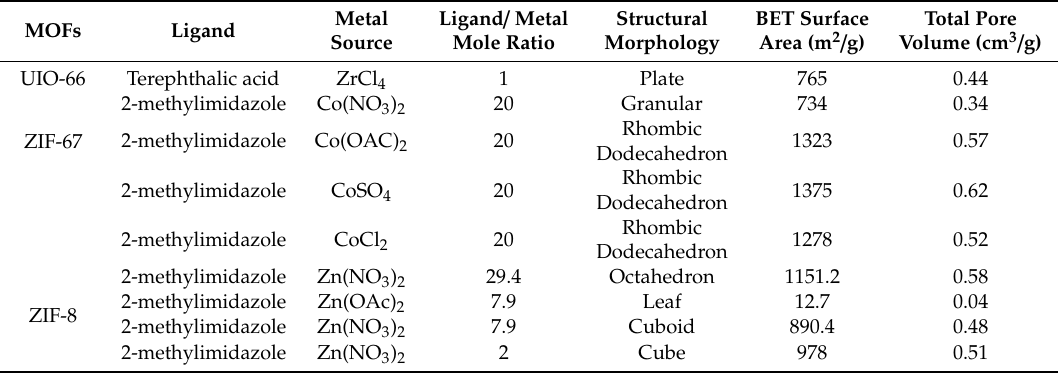
Table 2. Summary of synthesis condition and structural properties of as-synthesized metal-organic frameworks